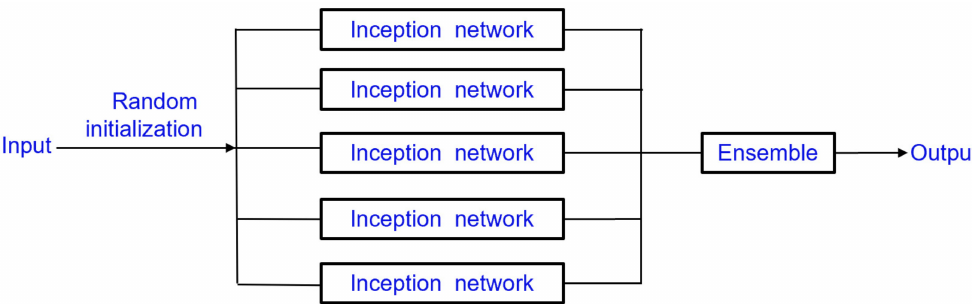
Figure 3. The ensemble of Inception networks.